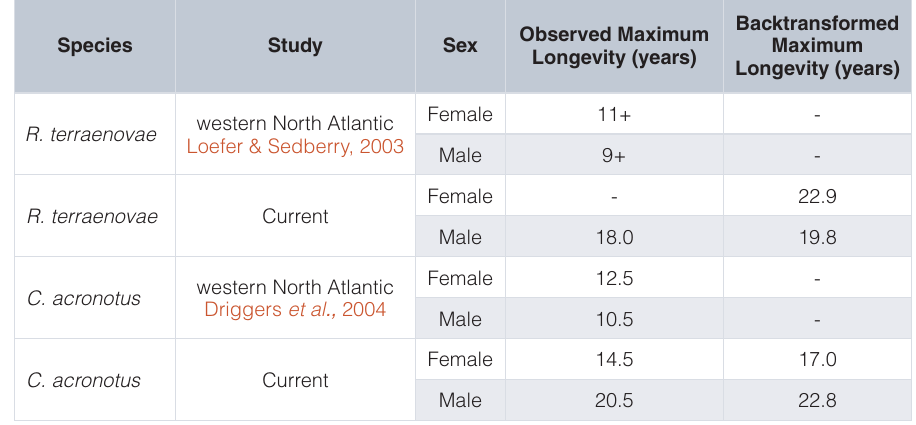
Table 2. Observed maximum longevity from sectioned age estimates, and backtransformed maximum longevity from tag and recapture data for Atlantic Sharpnose Sharks